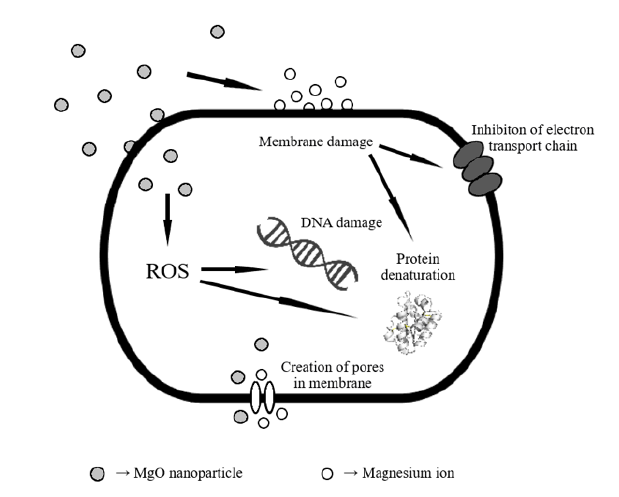
Figure 4. The antimicrobial action mechanism of MgO nanoparticles.